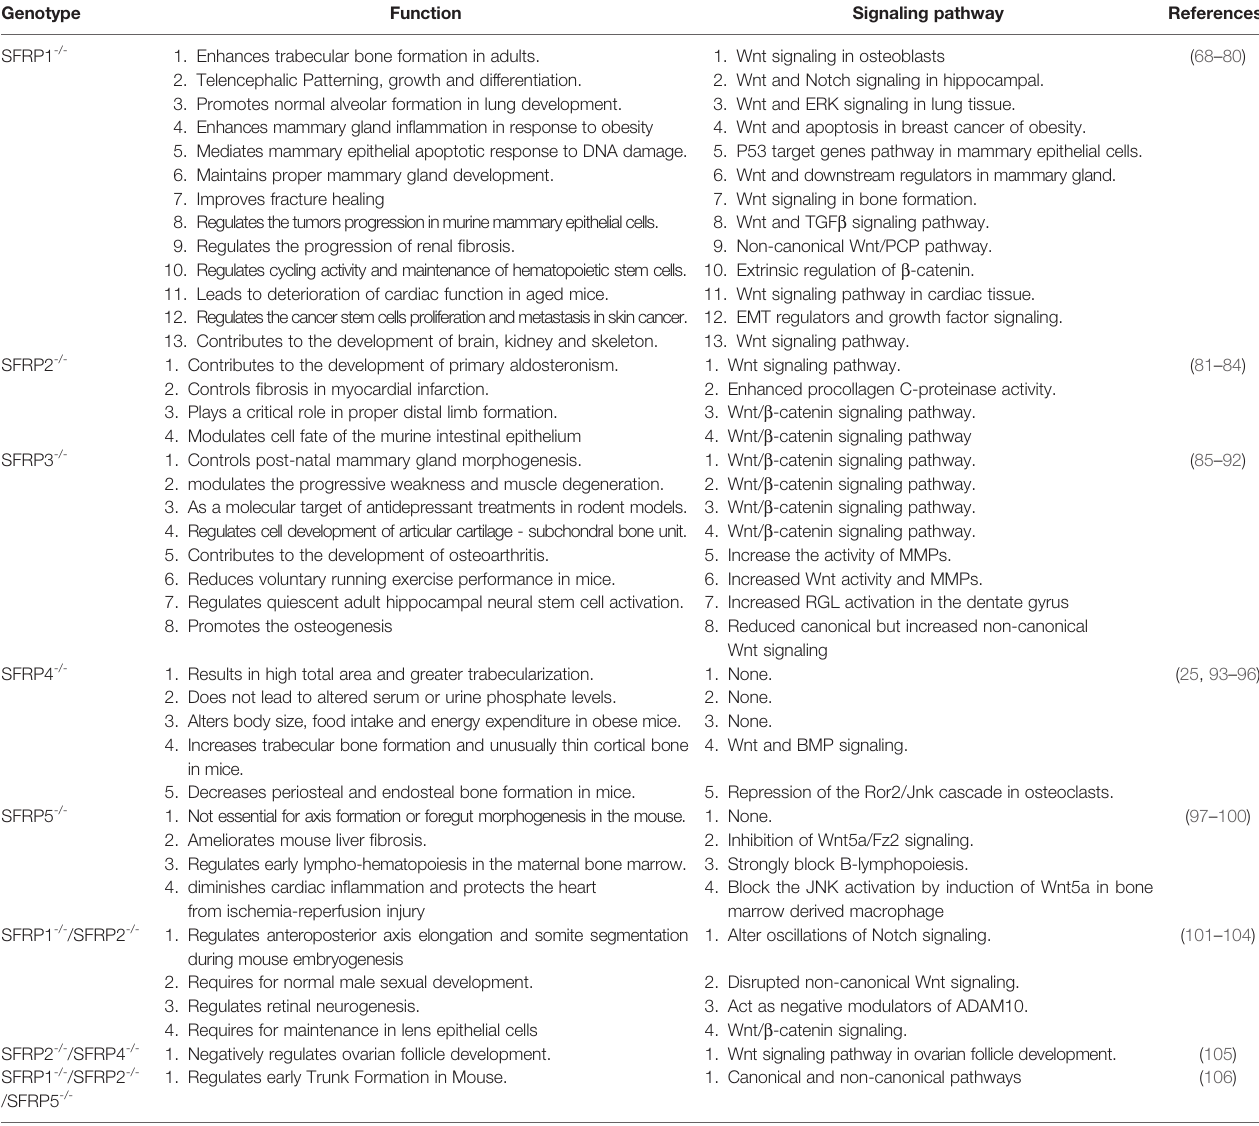
TABLE 1 | The overview of SFRPs knockout mice: Function and signaling